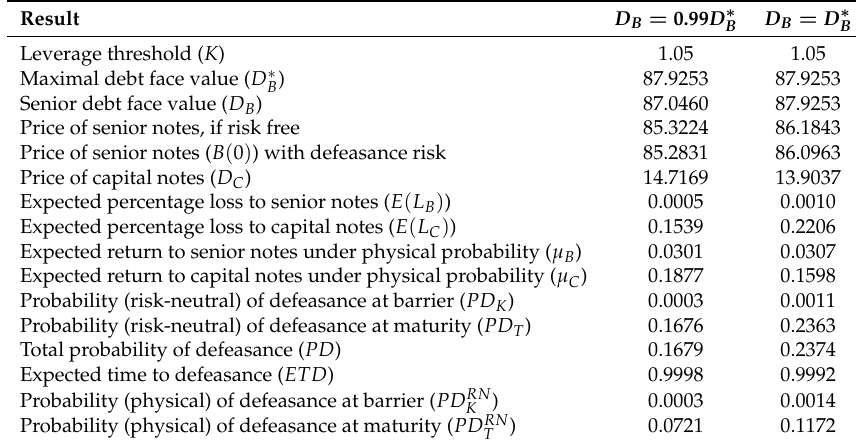
Table 3. Results for the SIV when leverage controls are imposed, i.e., K = 1.05. Results are shown for the case when senior debt is at its maximal amount, D ∗ , with expected percentage losses on senior B debt ( E ( L B ) ) equal to L 0 = 0.0010 (10 bps). Results are also shown for the case where senior debt is set to 99% of the maximal